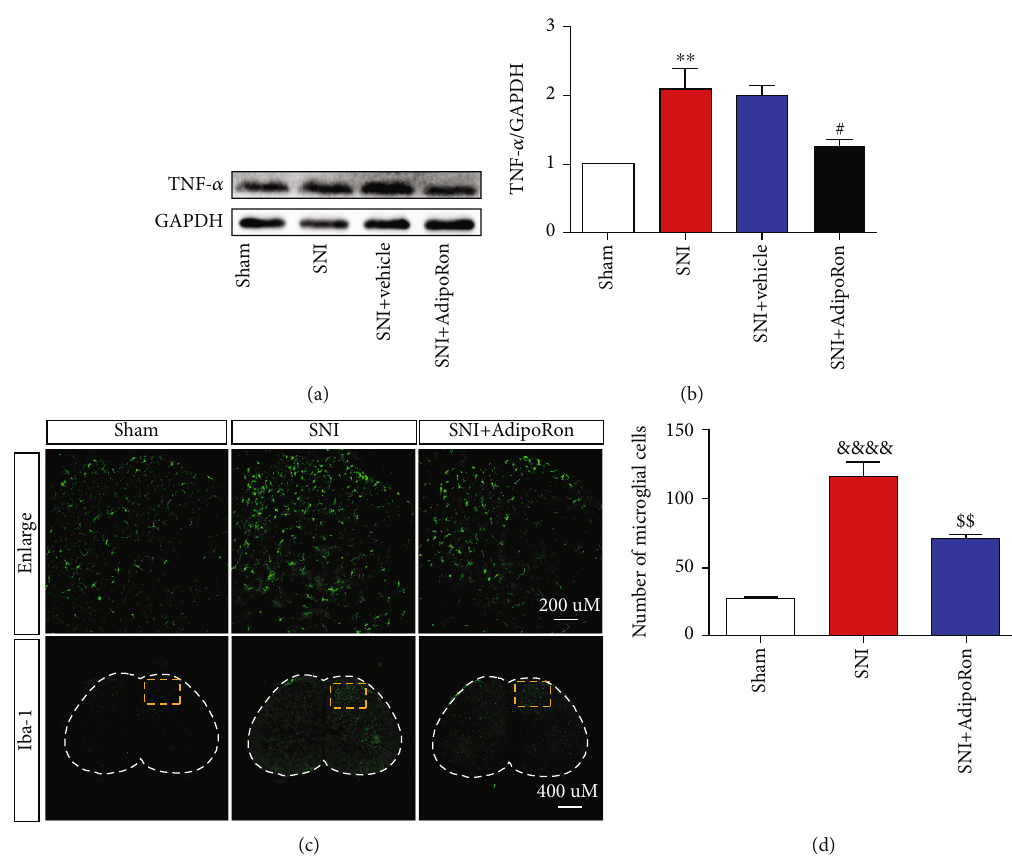
Figure 2: AdipoRon reduced the protein expression of TNF- α and the number of Iba-1-positive cells in the ipsilateral spinal cord of SNI mice. (a, b) Representative blots and quanti fi cation of the e ff ect of AdipoRon on the TNF- α protein expression in the ipsilateral spinal cord of mice on day 7 after SNI. (c) Representative fl uorescence images of microglia in the ipsilateral SDH (spinal dorsal horn) of mice on day 7 after SNI. Scale bar: 400 μ M and 200 μ M. (d) Summarized data for microglia numbers in the ipsilateral SDH from the three groups shown in (c). Data were presented as mean ± SEM ( n = 4 per group). ∗∗ p < 0 : 01 vs. Sham-Ipsi, # p < 0 : 05 vs. SNI+Vehicle-Ipsi, &&&& p < 0 : 0001 vs. Sham, and $$ p < 0 : 01 vs.